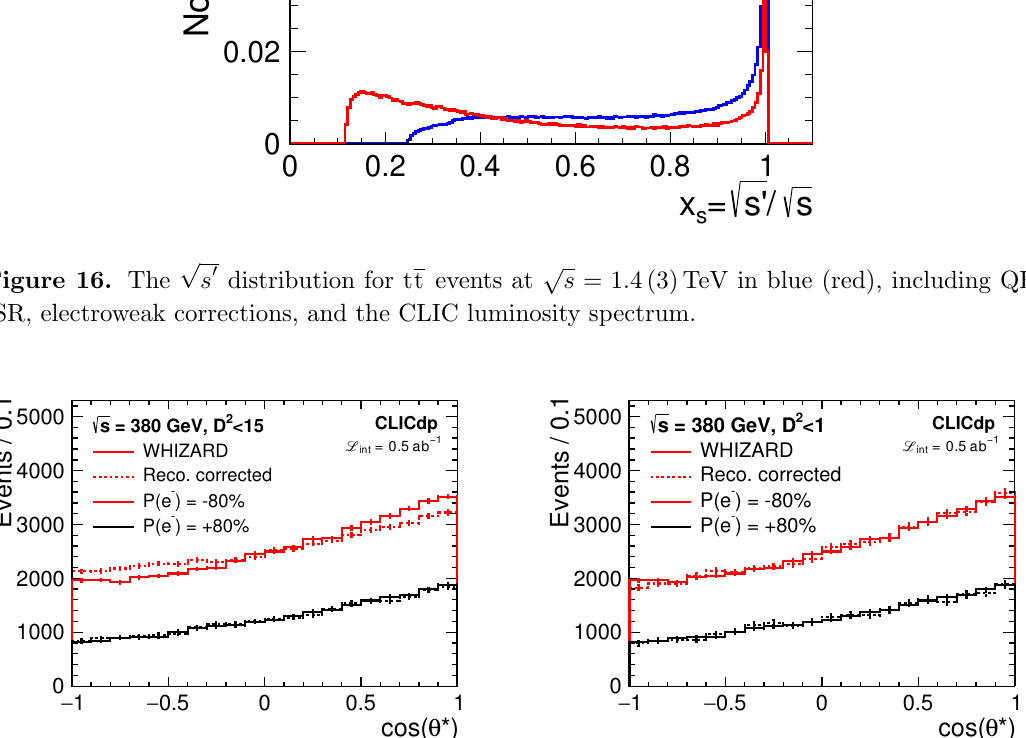
p Figure 17. Top-quark polar angle distributions for operation at s = 380 GeV after the application of a quality cut based on the kinematic variable D 2 . A cut of D 2 < 15 (1) was applied for the left (right) (cid:12)gure. The solid lines show the reconstructed distributions including the e(cid:11)ects of detector modelling, event reconstruction and candidate selection, while the dashed lines show the WHIZARD parton-level distributions, for the two beam polarisation con(cid:12)gurations considered. Note that e(cid:14)ciency corrections have been applied, corresponding to the parton-level expectation for D 2 <